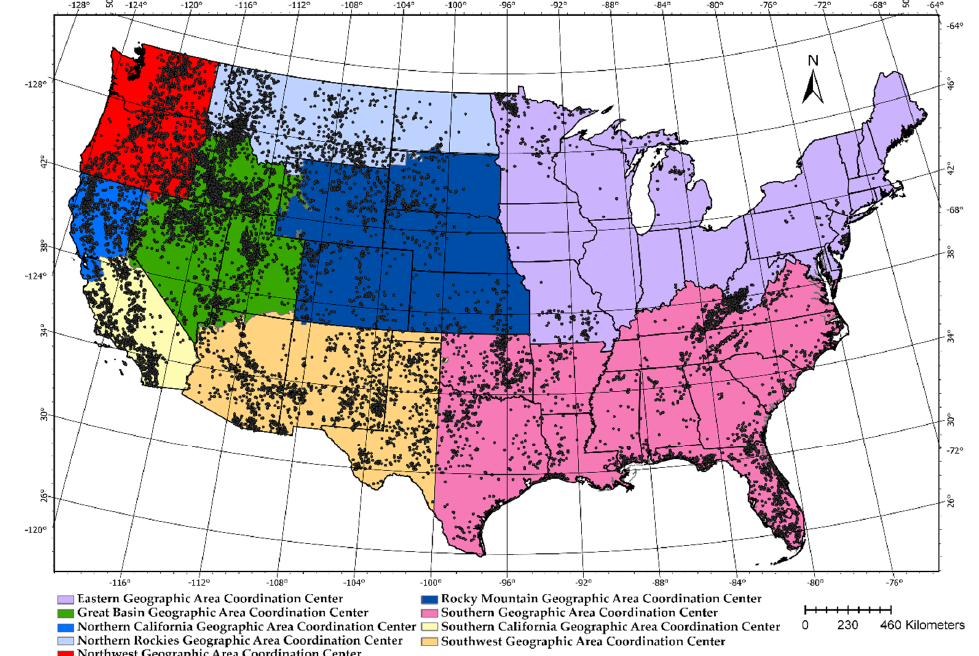
Figure 1. MTBS data (1984–2017), represented in the figure as black incident points, is overlaid across Contiguous US (CONUS) and framed by the nine Geographic Area Coordination Center (GACC) regions. The label for each GACC is seen in the legend.